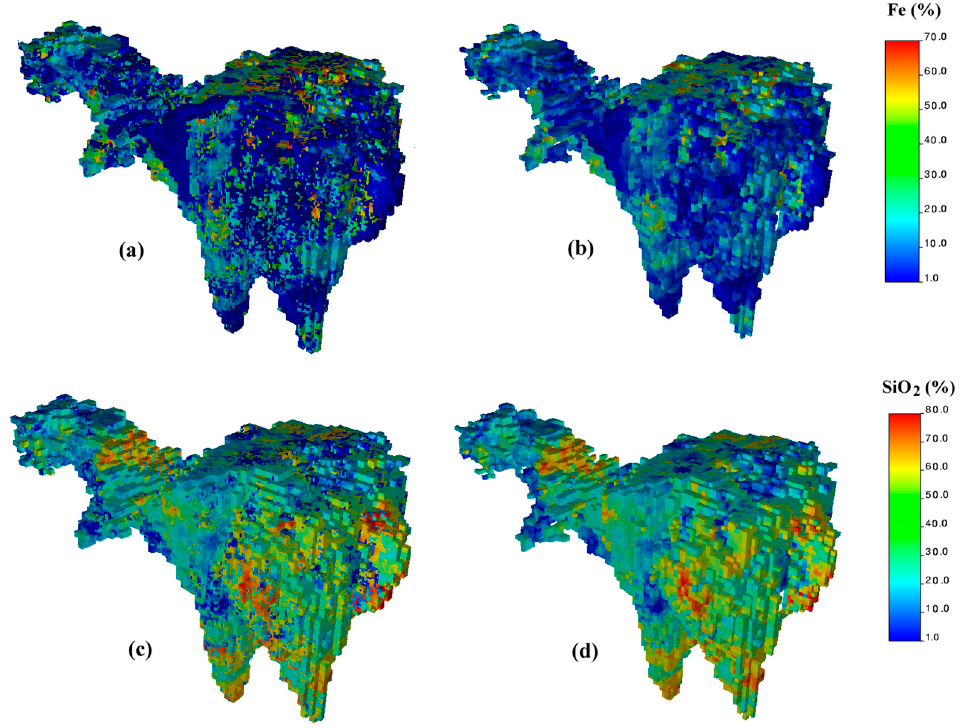
Figure 6. One realization of iron (top) and silica (bottom) grades at ( a , c ) a quasi-point support (before upscaling) and ( b , d ) a block support (after upscaling).